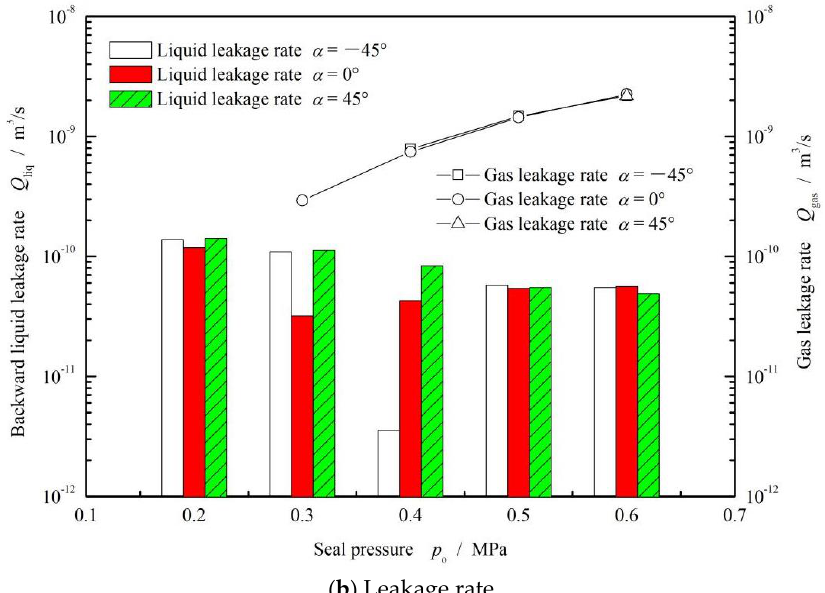
Figure 7. Effect of seal pressure on the opening force ( a ) and leakage rate ( b ). ( ω = 10,000 rpm, p o = 0.3 MPa, h 0 = 2 μm, γ = 3.5 and N = 36).